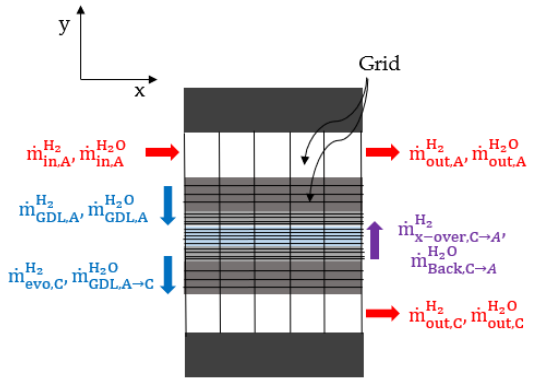
Figure 3. Schematic diagram of the mass balance applied to the anode and cathode.